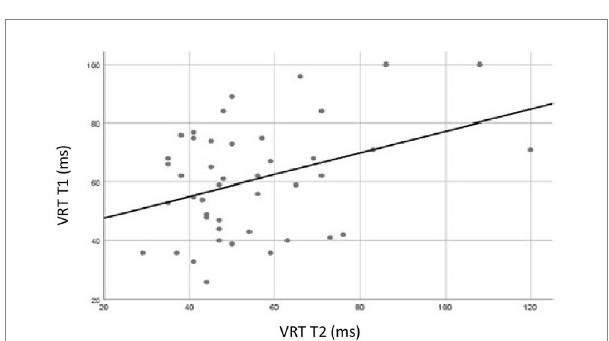
FIGURE 7 Pearson correlation analysis for variability of correct reaction time (VRT) of Brazilians participants tested two times, test vs. retest. In the X -axis, VRT data for participants exposed to retest. In the Y -axis VRT data for participants exposed to the first test. Correlation between test and retest was statistically significant for VRT ( r = 0.37, p =